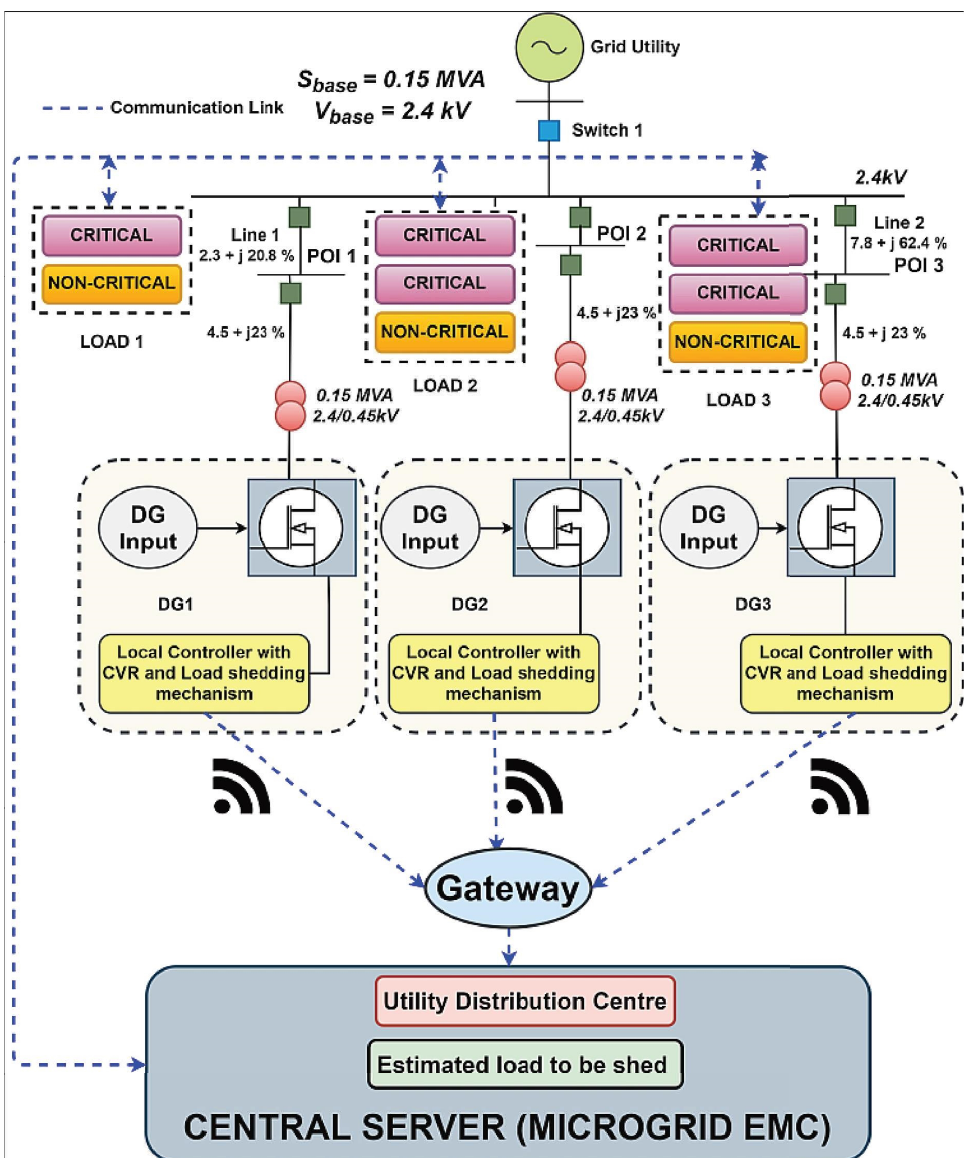
Figure 8: Single-feedermulti-DG test